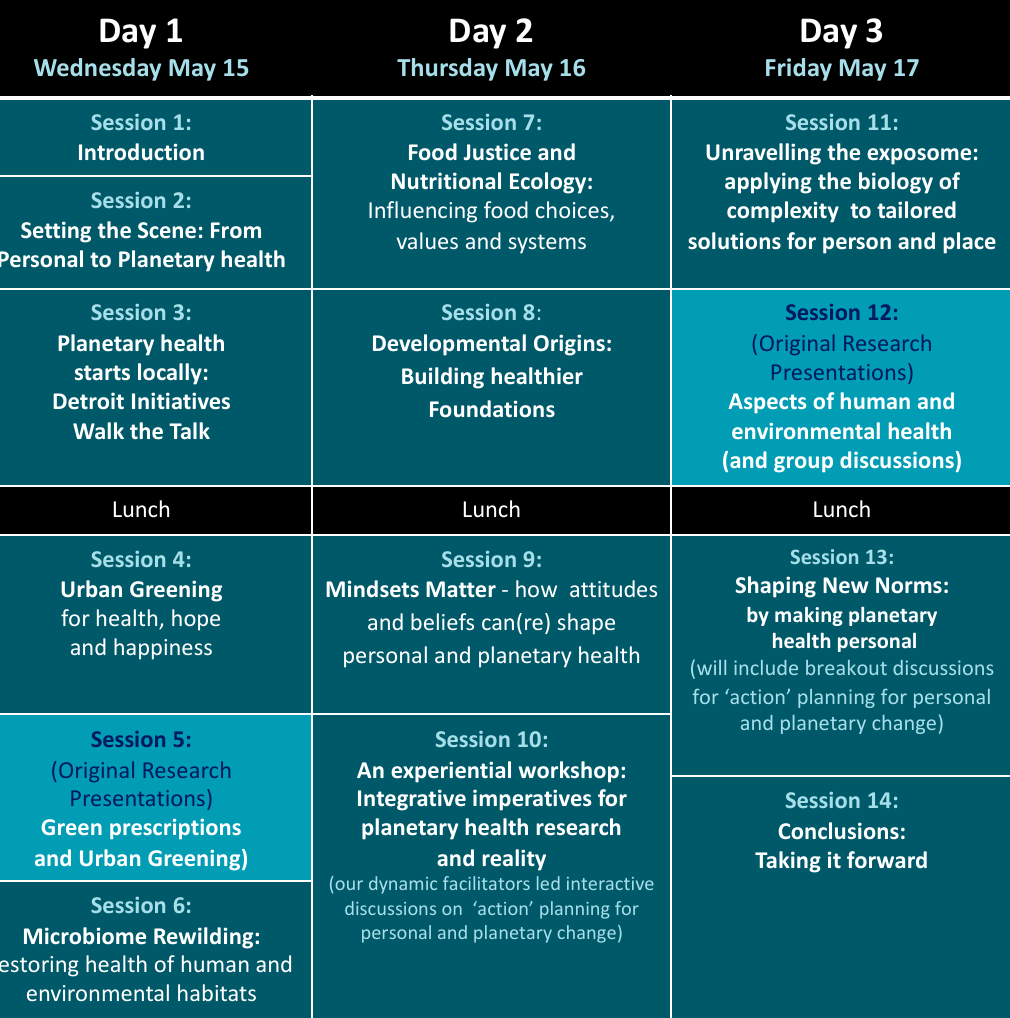
Figure 2. The Conference Program Overview: This shows the overarching structure of the meeting, demonstrating the flow and evolution of interdependent concepts as the meeting evolved. This structure is reflected in the order of the proceedings below (abstracts are presented from each of these sessions to provide further detail of the content).